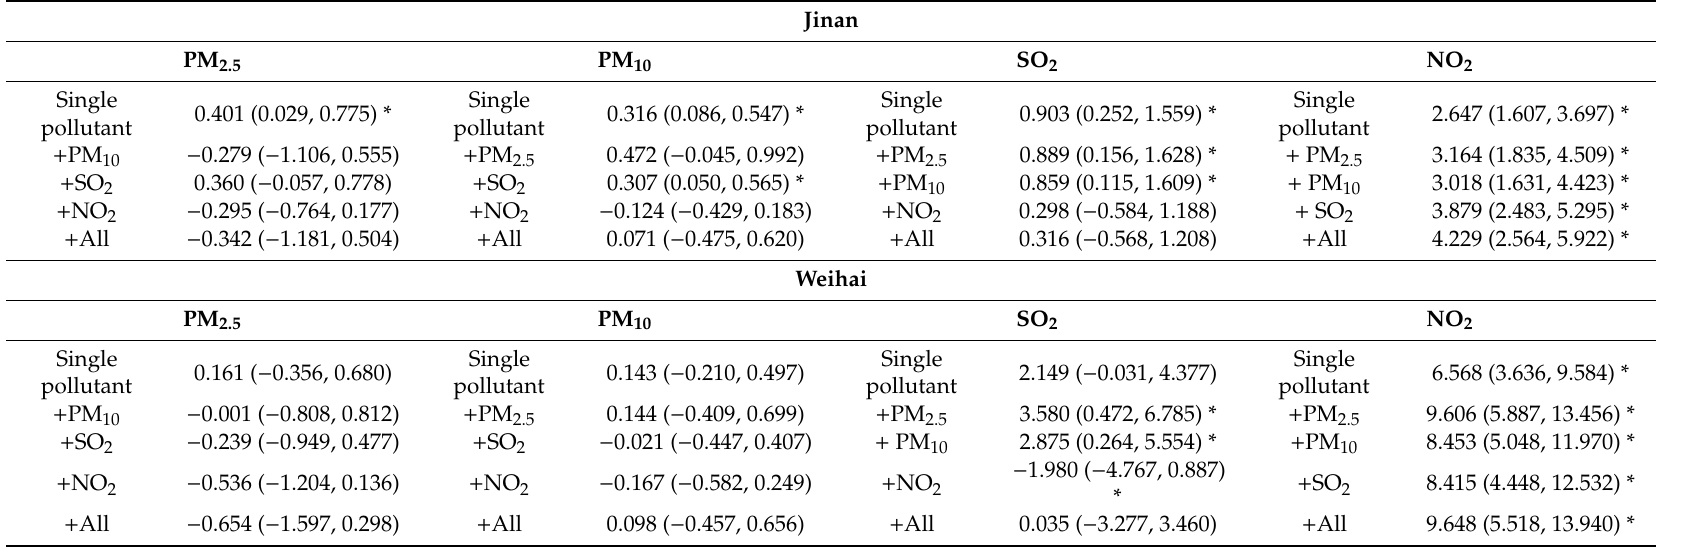
Table 2. The percentage change in the relative risk of the total cardiovascular disease hospitalizations with a 95% confidence interval (CI) per 10 µ g / m 3 increase in the air pollution levels estimated from multipollutant models, where * indicates statistically significant estimates ( p < 0.05).